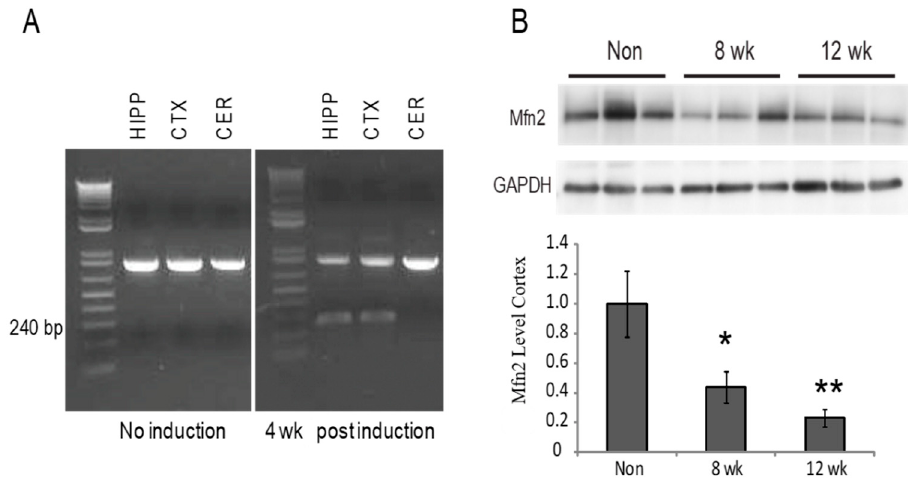
Figure 1. Decreased Mfn2 protein levels following recombination. PCR confirms the recombination product in the brains of transgenic mice, and 4 weeks after induction with tamoxifen, the hippocampus and cortex also had the excised band at 240 bp, while the cerebellum did not have the excised band ( A ). Western blot analysis of cortical lysates found significant loss of Mfn2 protein in the 8 weeks and 12 weeks post-induction Mfn2 iKO mice ( B ) * p < 0.05; ** p < 0.01.